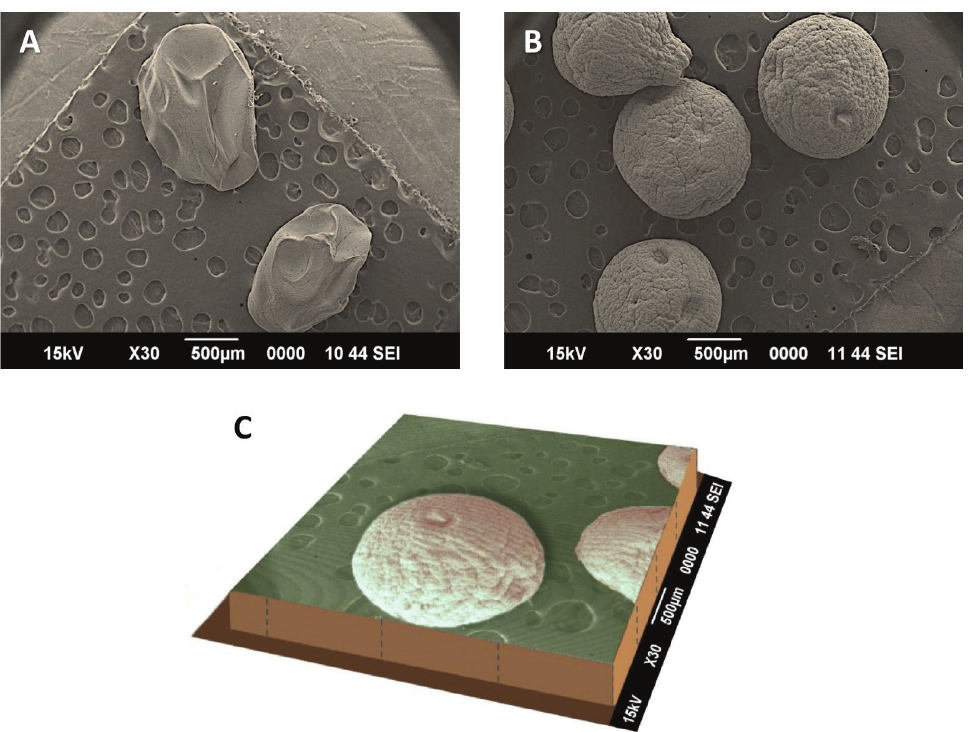
Figure 1: ( A ) Beads made of alginate depicted as a control; ( B ) Microspheres made of Portulaca-alginate-epichlorohydrin (double crosslinked hydrogel beads); and: ( C ) Three dimensional representation of scanning electron micrograph depicting the overall shape and surface morphology of Portulaca-alginate-epichlorohydrin double crosslinked hydrogel beads encapsulating the anticancer agent